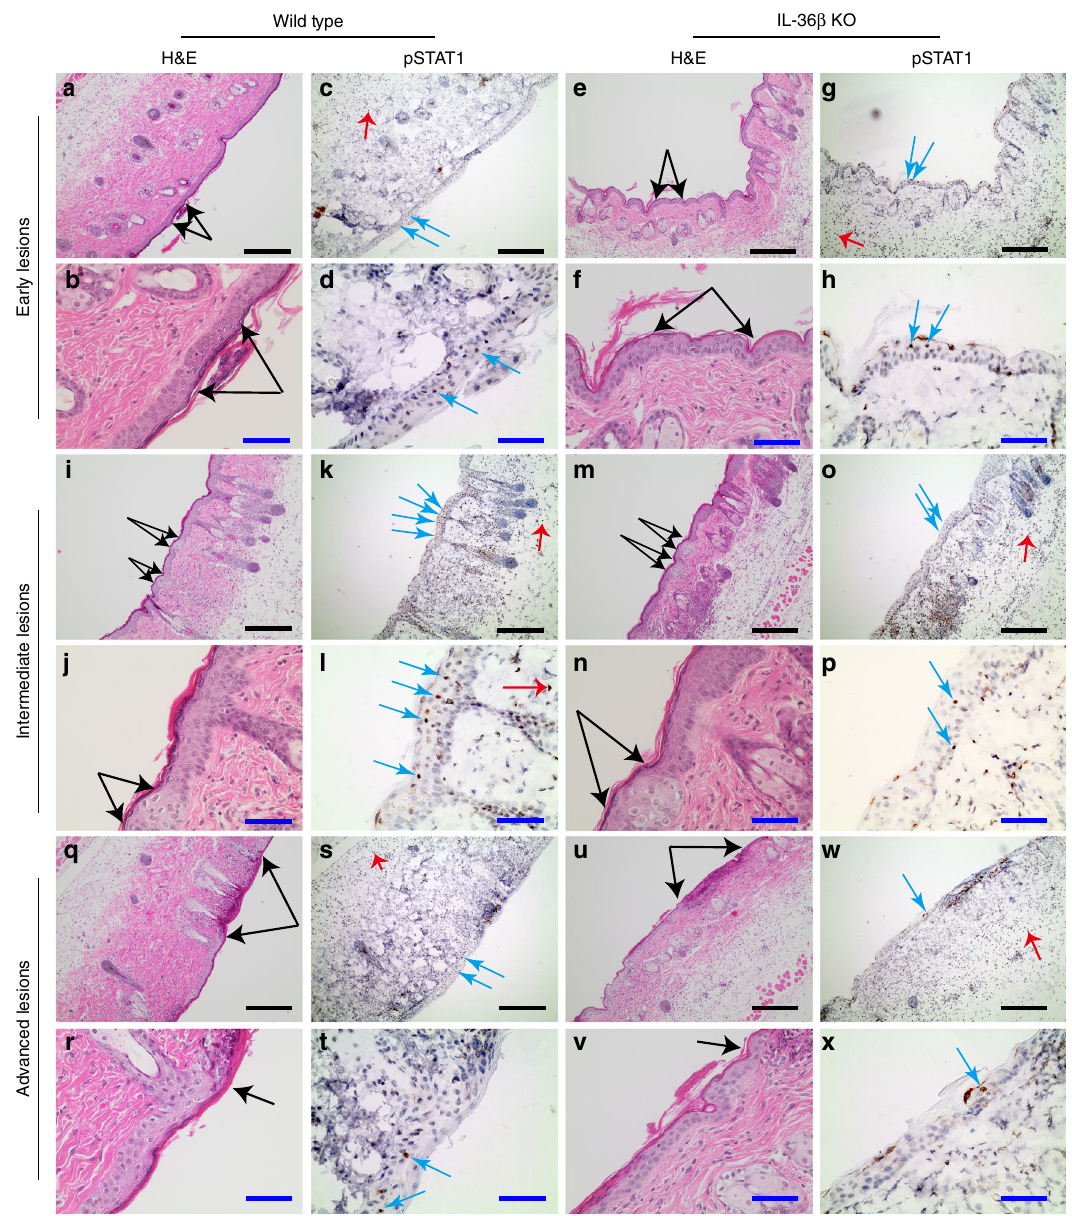
Fig. 3 STAT1 is activated in epidermal keratinocytes during HSV-1 infection. Wild type and IL-36 β KO mice were infected with HSV-1 and skin along the dermatome collected 5 days later. Consecutive skin sections were examined by H&E and pSTAT1 immunohistochemistry. Early ( a – h ), intermediate ( i – p ), and advanced ( q – x ) lesions are shown. Black, blue, and red arrows point to lesion edges and positive pSTAT1 nuclei in keratinocytes and leukocytes, respectively. Black and blue scale bars represent 200 and 50 μ m,